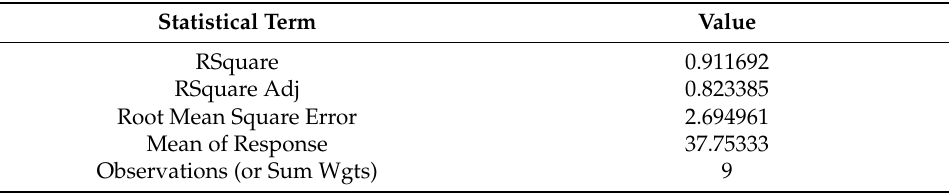
Table 9. Summary of fit for K1-based samples.